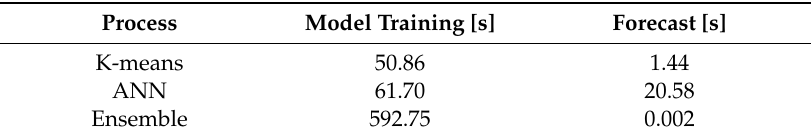
Table 3. The computation time of